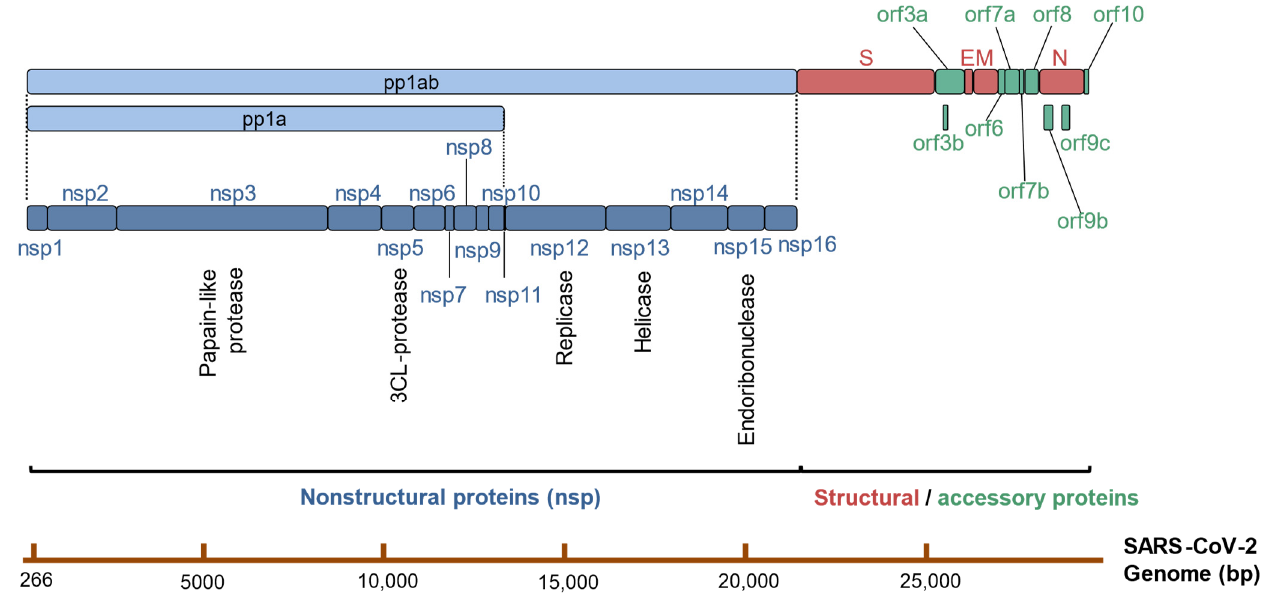
Figure 1. The principal scheme of the SARS-CoV-2 genome. Bars on the bottom represent each known viral protein, and size of each bar is determined by the length of its coding sequence. Dark light bars indicate the coronaviral polyproteins pp1ab and pp1a. Dark blue bars stand for the non-structural proteins, red bars represent structural proteins, and green bars imply accessory proteins.